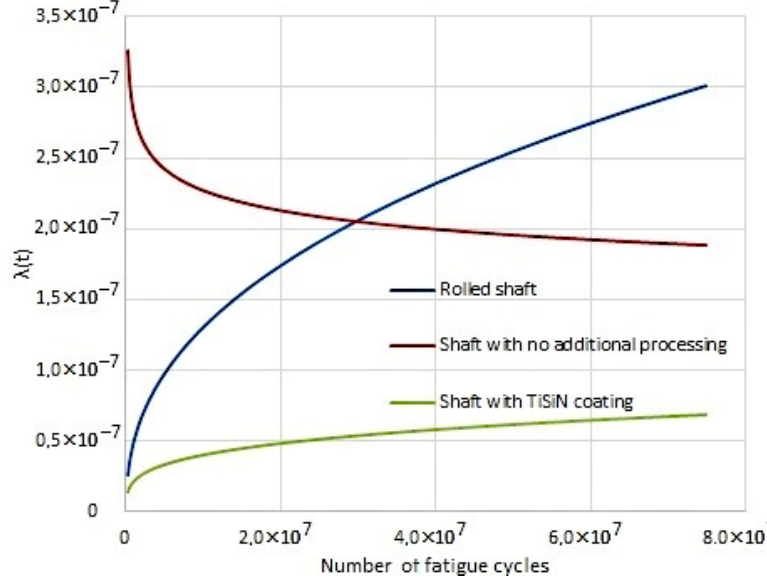
Figure 10. The course R(t) and F(t) for shaft with TiSiN coating.